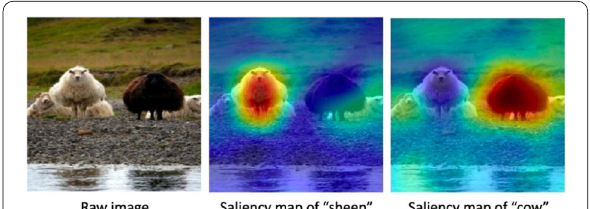
Figure 11 Example of saliency maps, adapted from Ref.